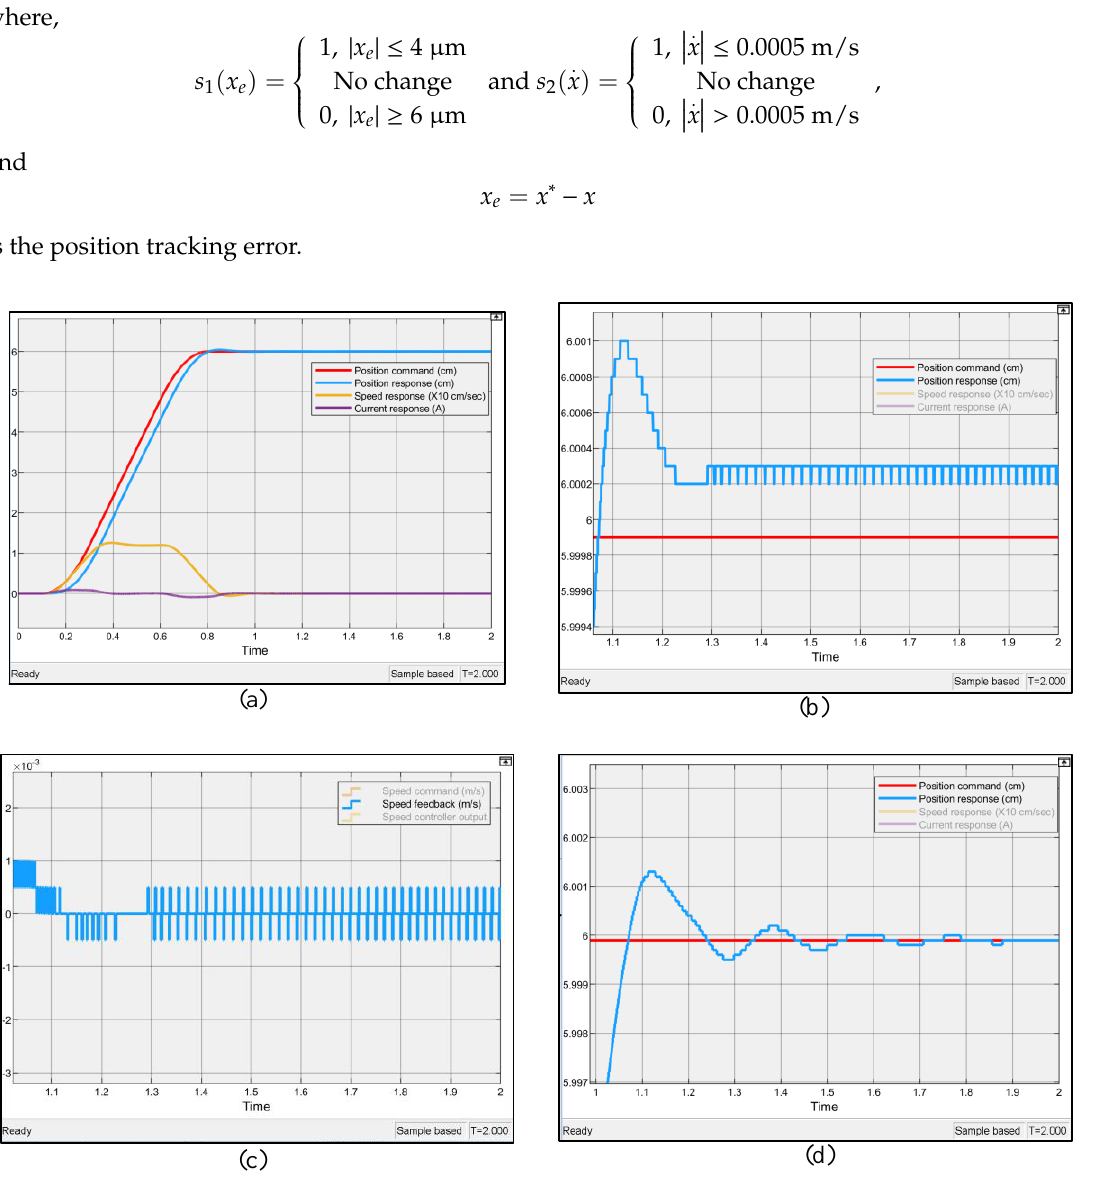
Figure 10. The simulation results. ( a ) The complete position, speed and current responses. ( b ) The detailed steady-state position response. ( c ) The detailed steady-state speed response. ( d ) The detailed position response with switching control.